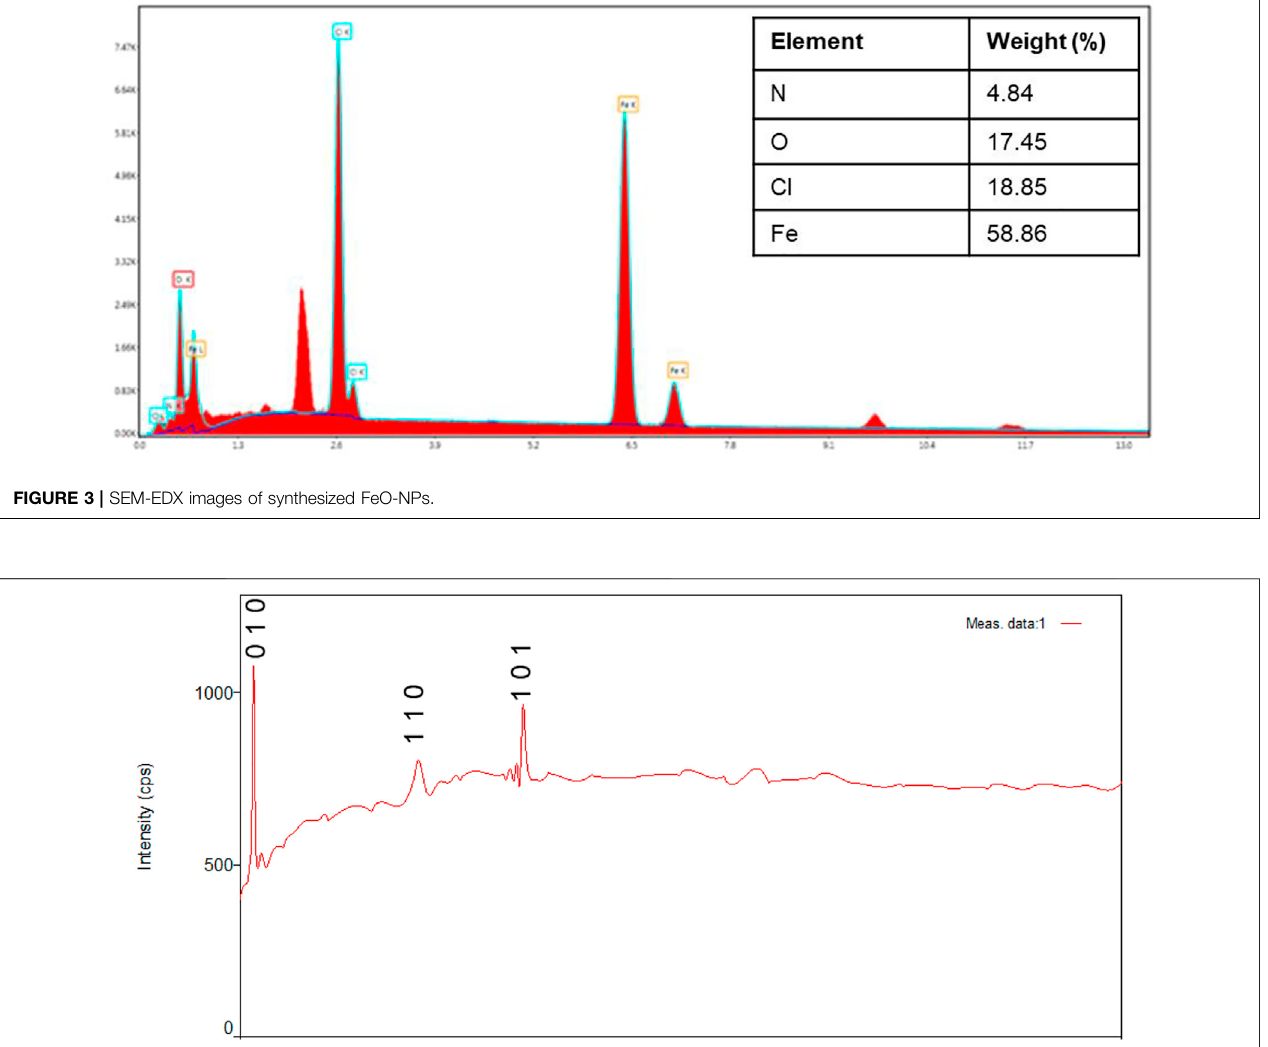
FIGURE 4 | XRD pattern of